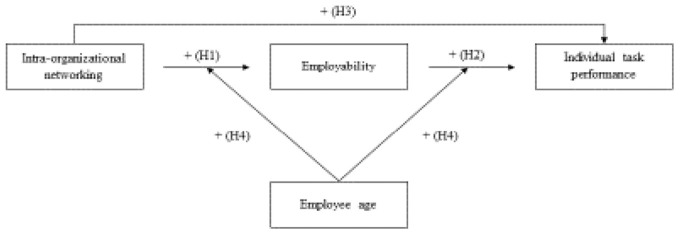
Hypothetical model.